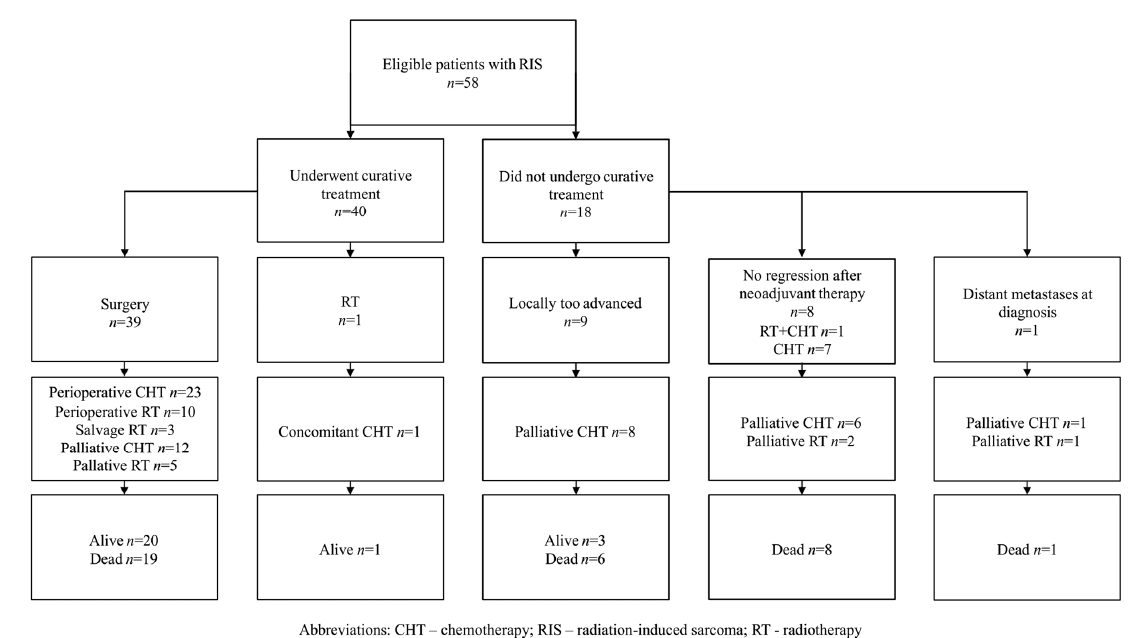
Figure 1. Applied methods of treatment in analyzed cohort.